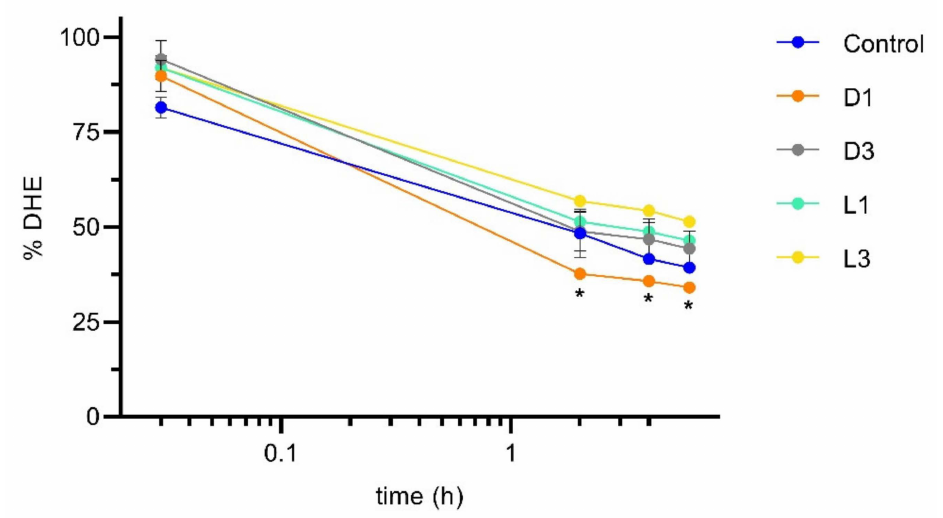
Figure 4. Amount of DHE in suspension in the donor (apical) compartment in permeability assays using Caco-2 monolayers. The sterol DHE (10 µ M) was emulsified by GCA (10 mM) in the absence (control) and in the presence of distinct coffee brews (expresso like coffee diluted 16 times). The amount of DHE is given as % of that in the sample before addition to the cells. Statistically significant differences from the control are indicated by * ( p < 0.05, n =